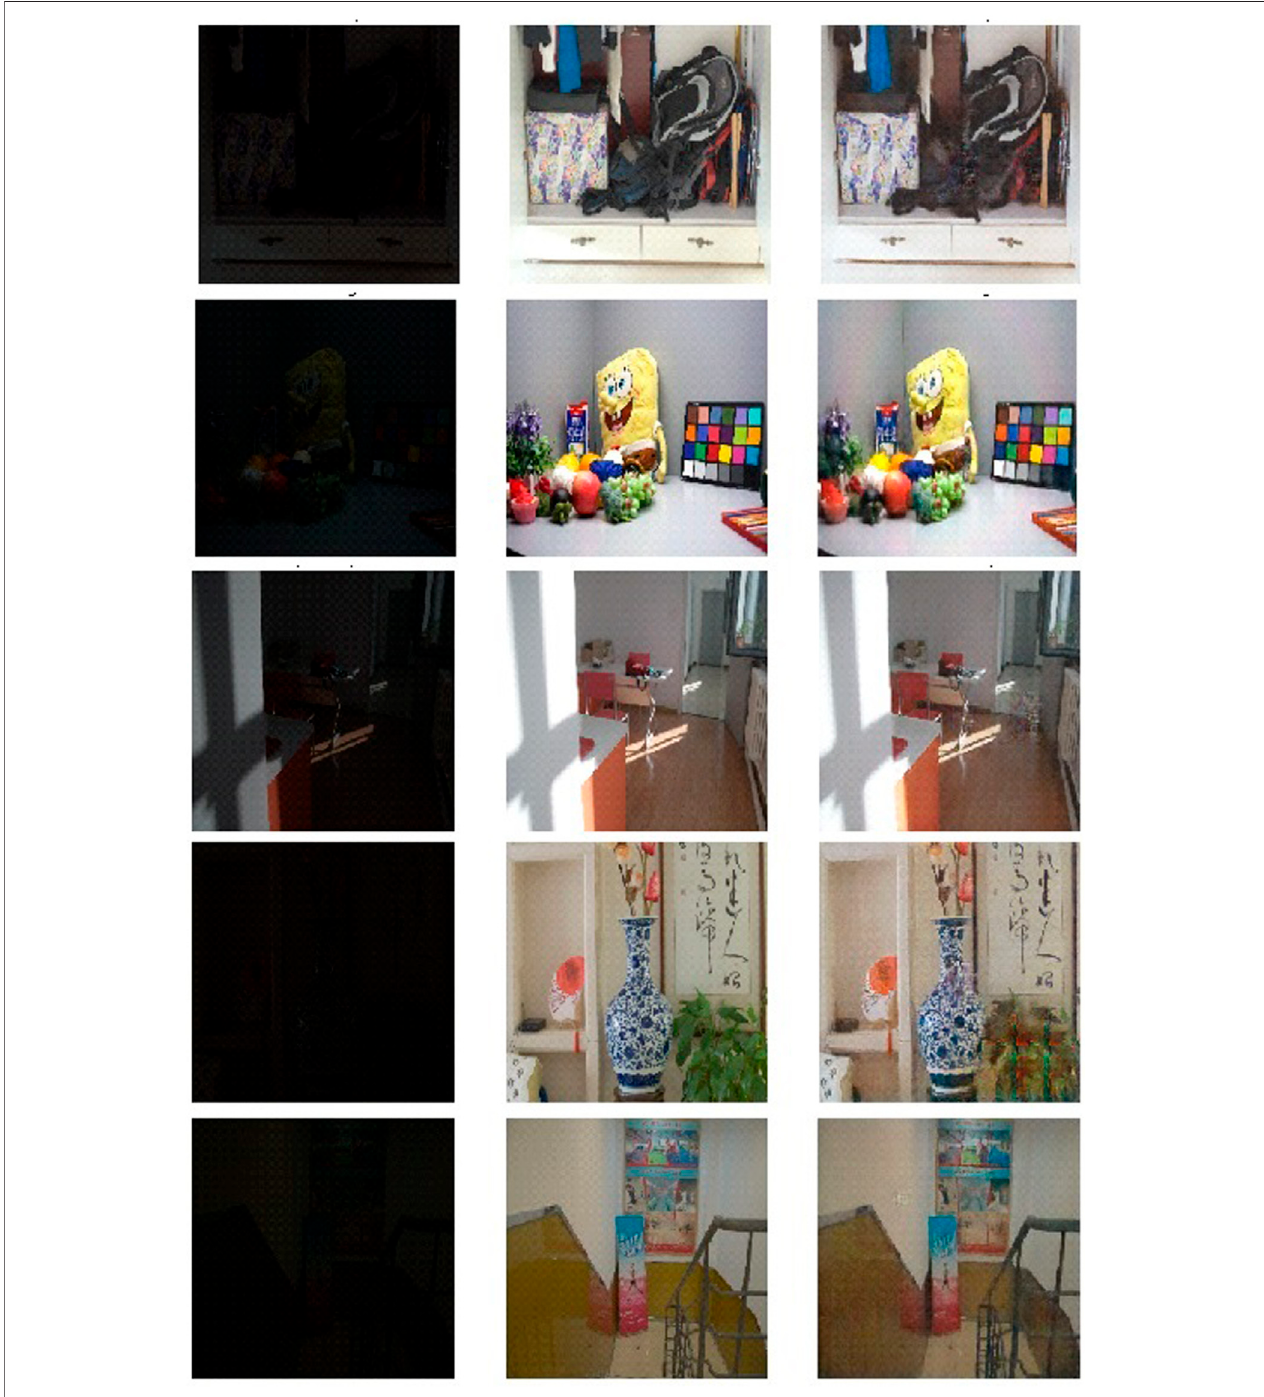
FIGURE 1 | Left Column: Natural low-light images. Middle Row: Ground truth images. Right Column: The results enhanced by our method.